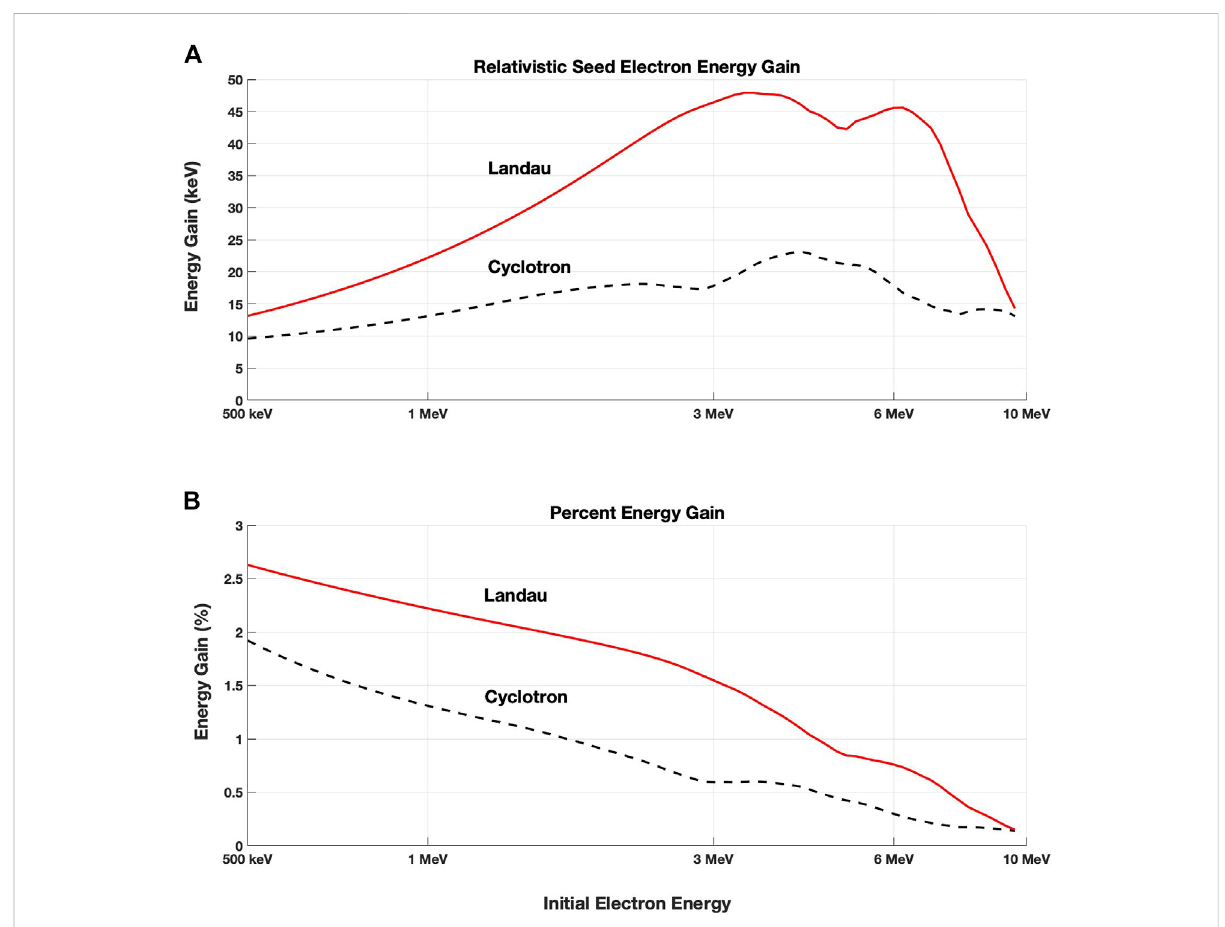
FIGURE 12 Nonlinear energygain isshown for relativistic and ultra-relativistic seed electrons. (A) Energygains forcyclotron andLandauresonant electrons are shown separately. Landau resonant energization exceeds cyclotron energization at all energies. (B) 0.5% – 2% energy gain is determined for highly-relativistic and ultra-relativistic seed electrons in their ~11 ms nonlinear interaction with the single strong subpacket denoted in Figure